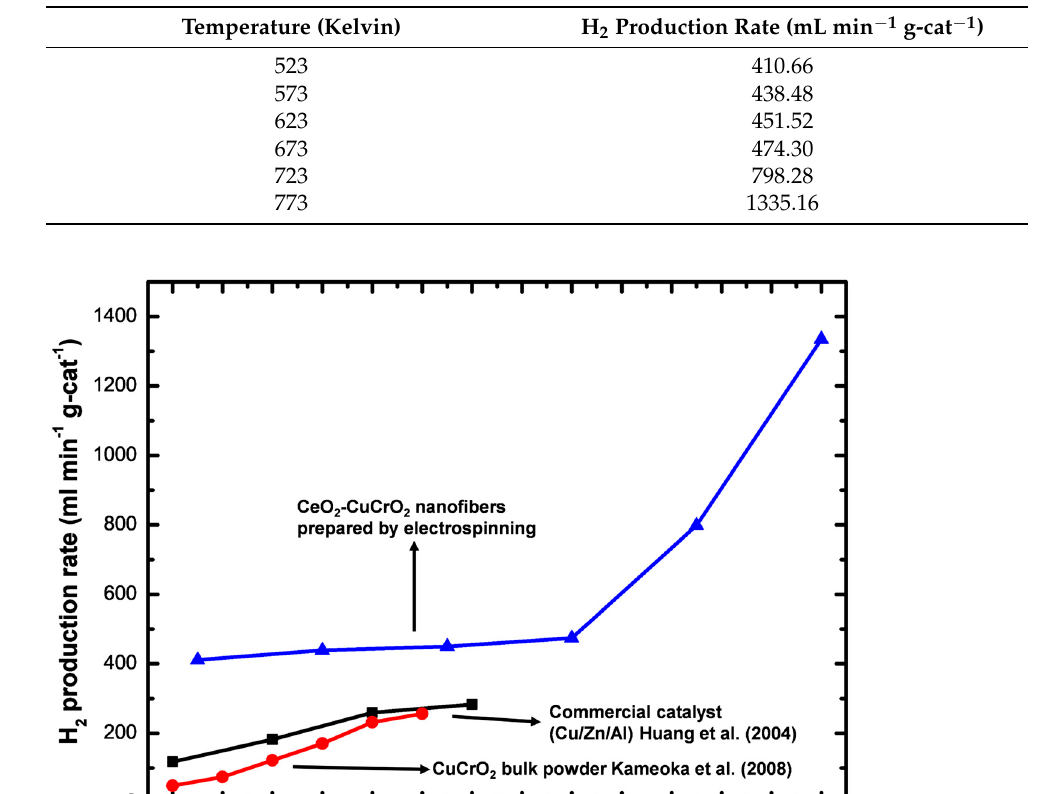
Table 2. Hydrogen production rate of CeO 2 -CuCrO 2 nanofibers at different temperatures.